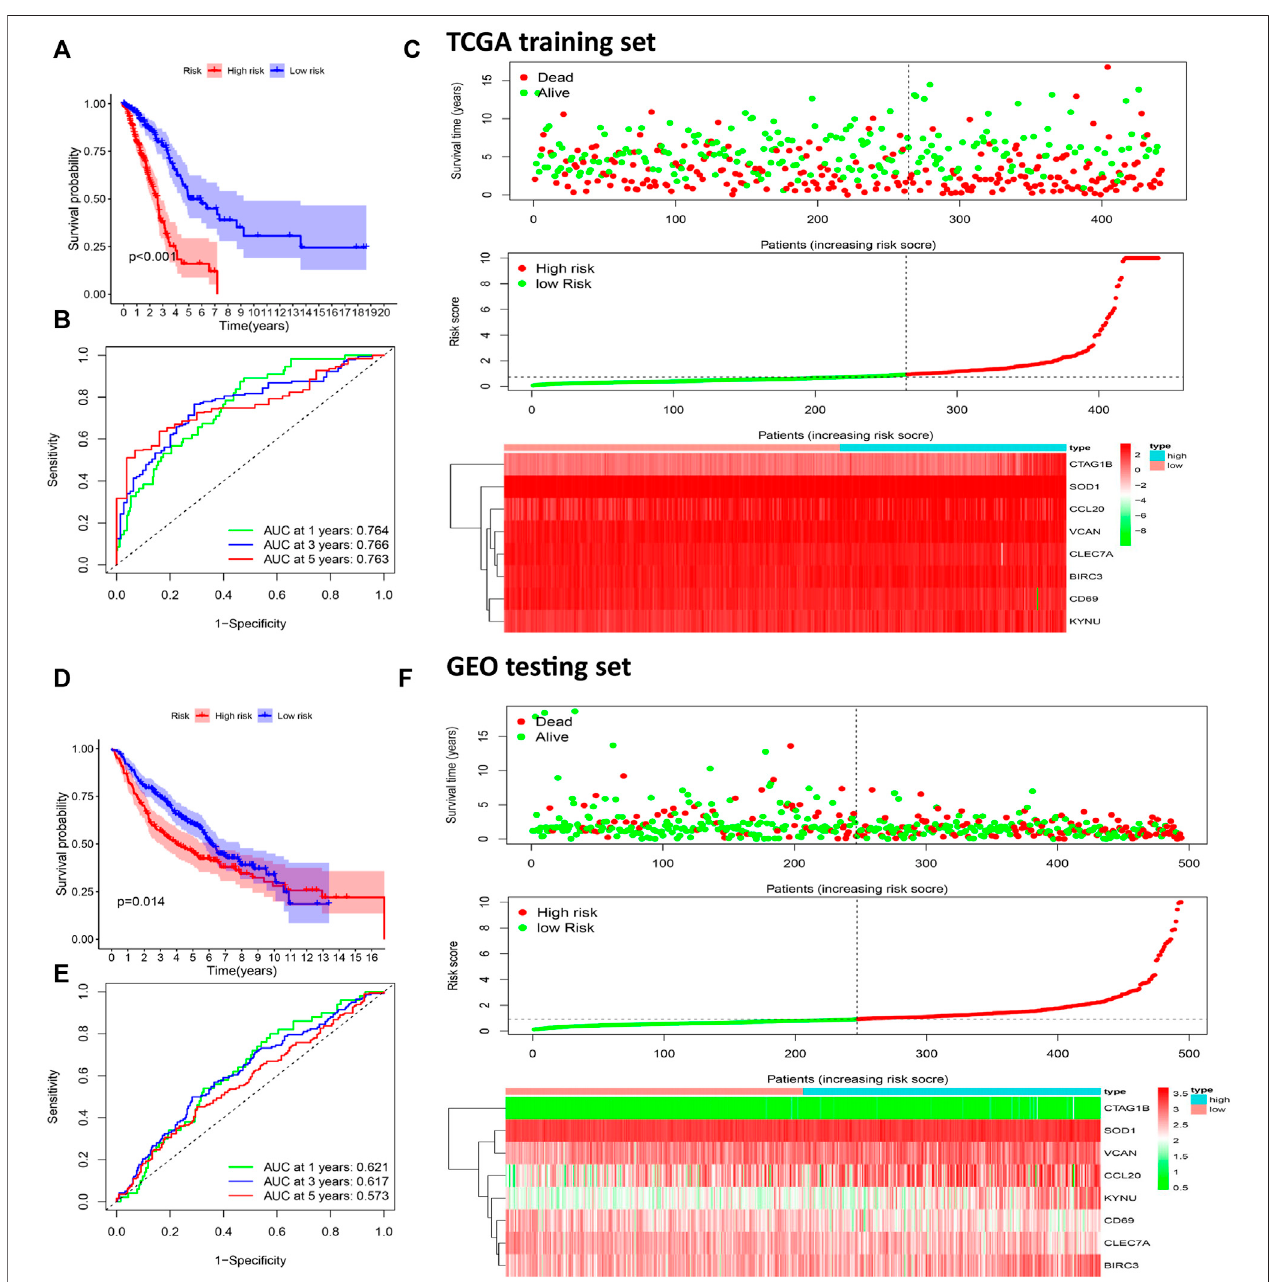
FIGURE 5 | Construction of a prognostic risk scoring model to predict LUAD patient survival. Kaplan-Meier survival analysis was performed to calculate the OS of high-riskandlow-riskgroupspatientsintheTCGAtrainingset (A) andGEOtestset (D) .TheROCcurvewasusedtoverifytheabilityoftheriskmodeltojudgethe1-,3-, and 5-year OS rates of patients in the TCGA (B) and GEO set (E) . Risk score analysis of eight prognostic-related genes in TCGA (C) and CGGA (F) sets. Upper: The survival status and time of LUAD patients distributed by risk score. Middle: The patients were classi fi ed into a high-risk group or a low-risk group by using the median value of the risk score. Bottom: Heat maps of the expression levels of eight prognostic-related genes.